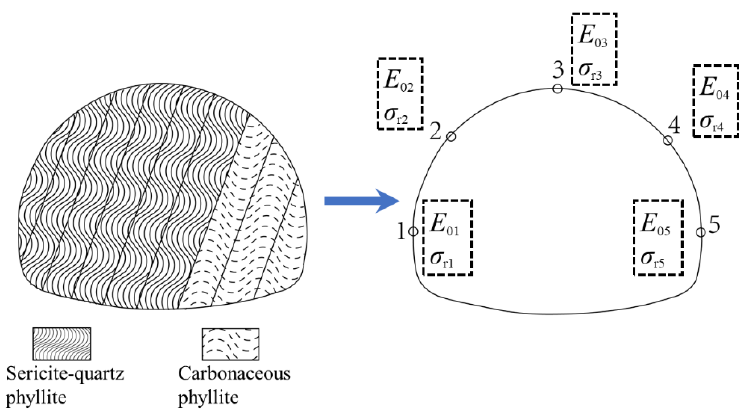
Figure 4. Surrounding rock mass strength parameters based on the Hoek–Brown failure criterion.